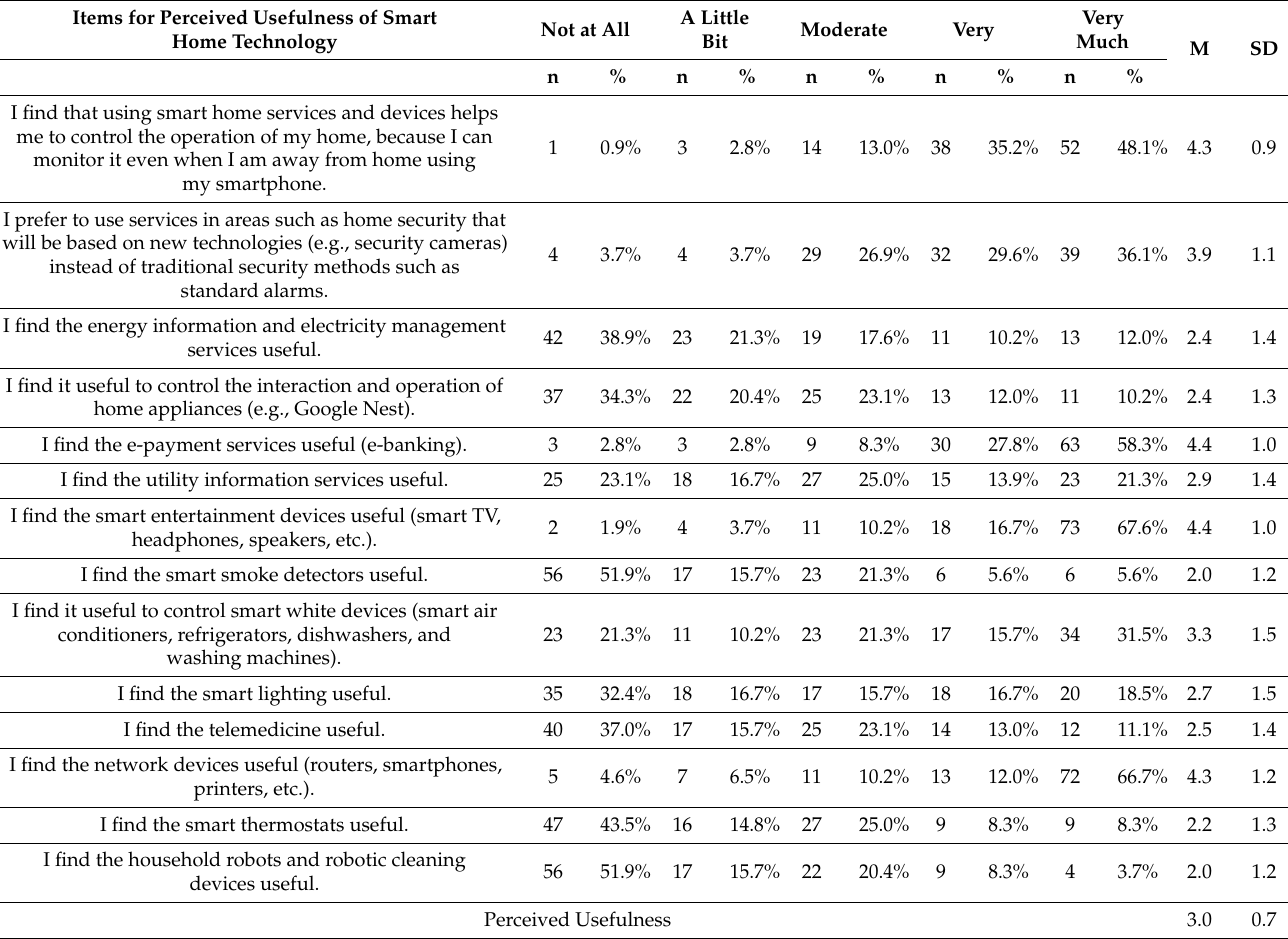
Table A1. Perceived usefulness of smart home technology.